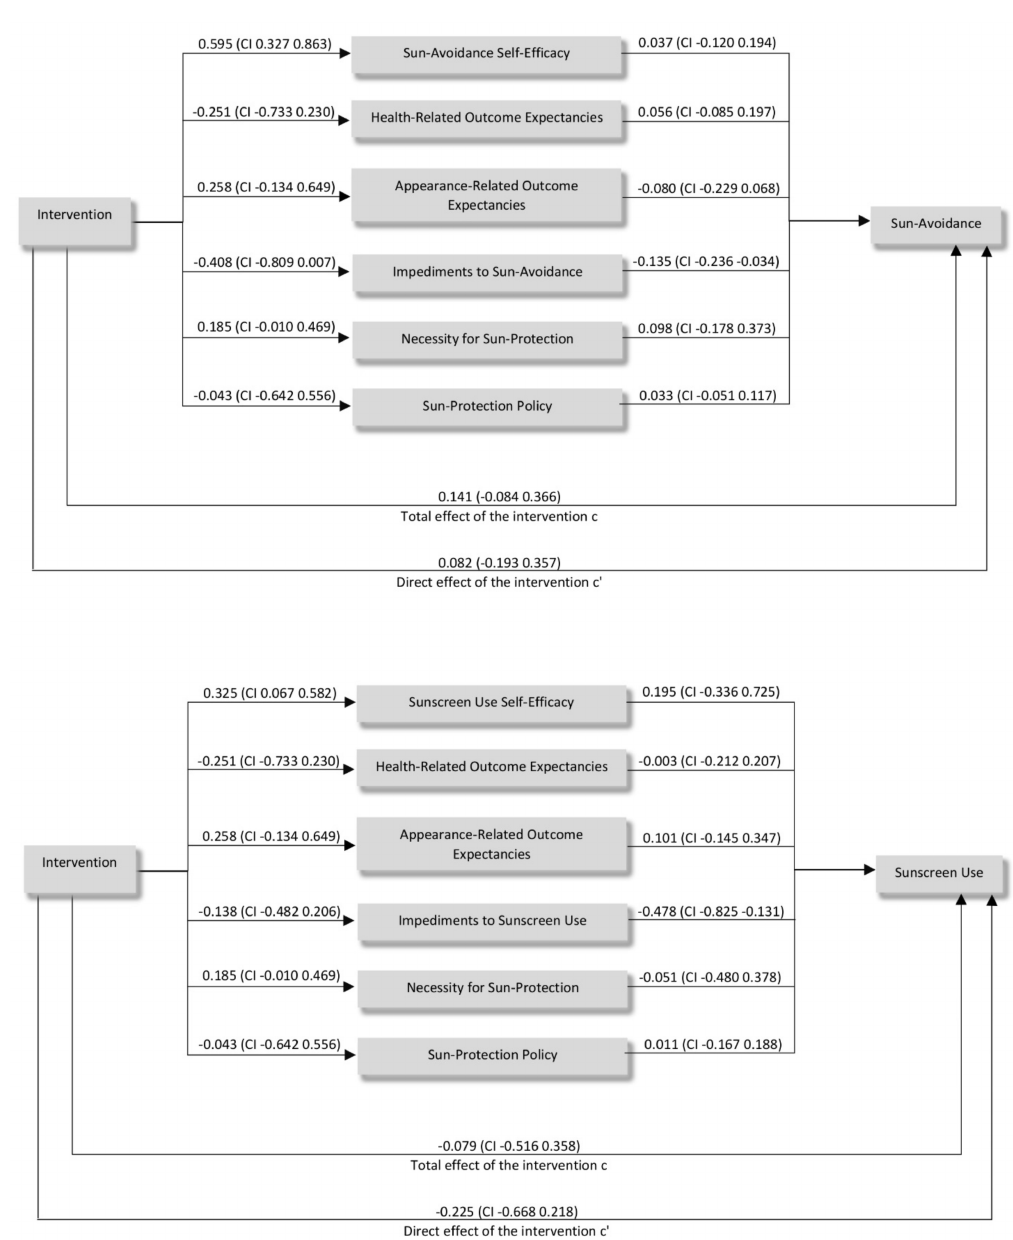
Figure 5. Mediation analyses pathways for changes in Sun-Avoidance Behavior and Sunscreen Use